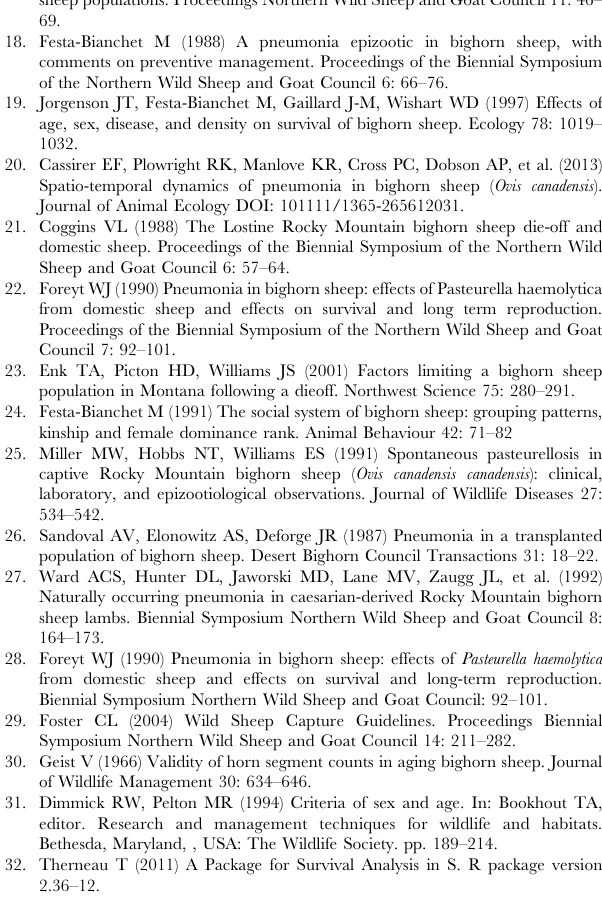
Table S1 Ewe relative risk of dying as a function of birth year pneumonia status for cementum-aged ewes. Table S2 Lambs: logistic regression